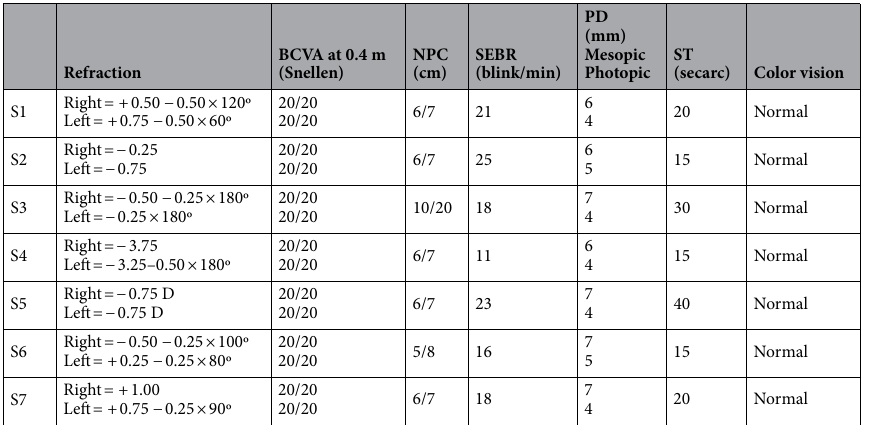
Table 1. Descriptive visual parameters of the participants. BCVA Best corrected visual acuity at 40 cm, NPC Near point of convergence, first value (break), second value (recovery), SEBR Spontaneous eye blink rate, PD Pupil diameter, ST